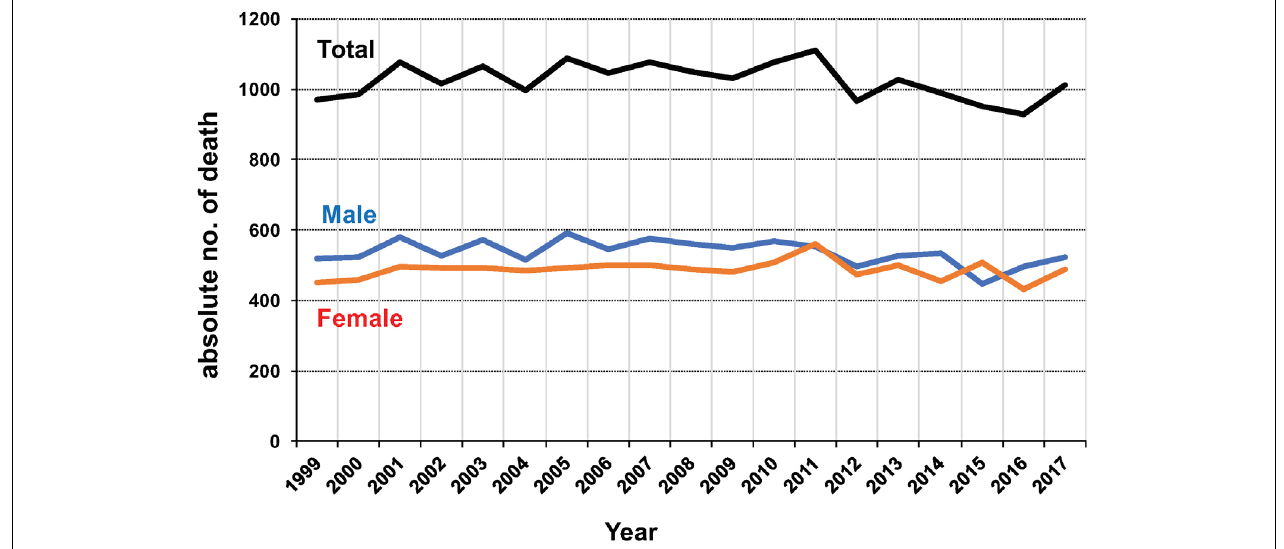
FIGURE 3 | Annual numbers of deaths from adult T-cell leukemia (ATL) in Japan during 2001–2010. The data were obtained from vital statistics on the Portal Site of Official Statistics of Japan (e-Stat) (accessed March–April 2019). Abbreviations: M, male, F,